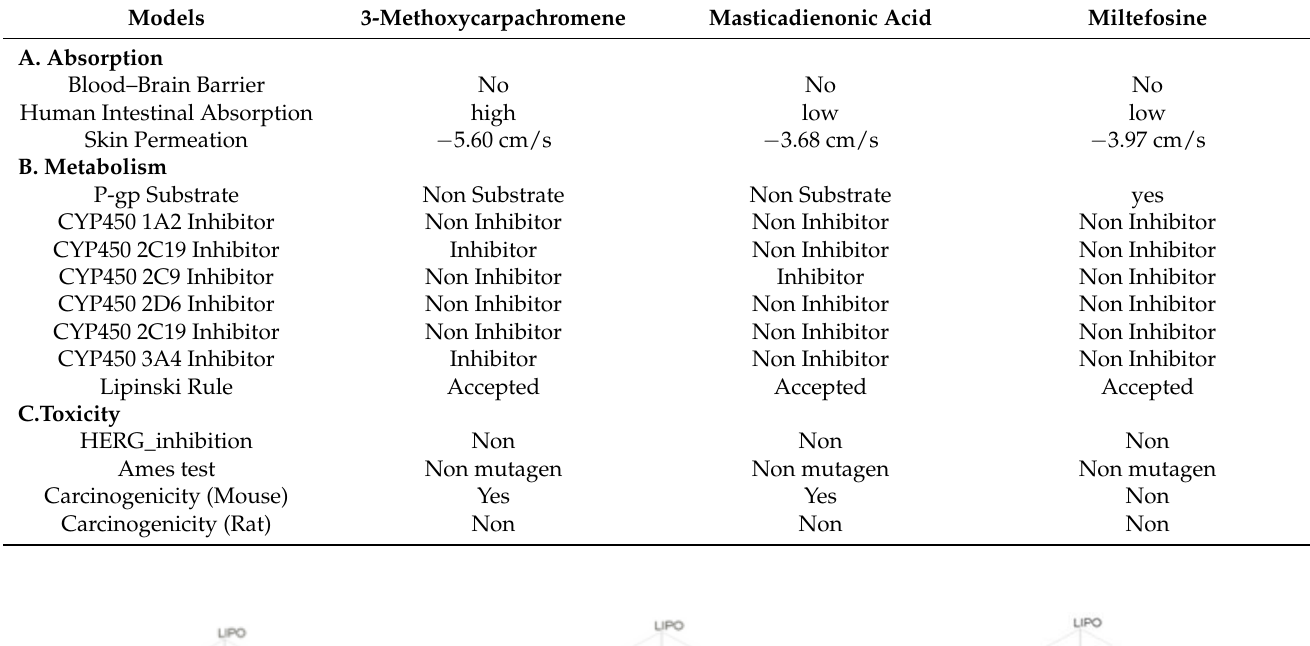
Table 4. ADMET profiling enlisting absorption-, metabolism-, and toxicity-related drug-like parameters of the two selected ligands.